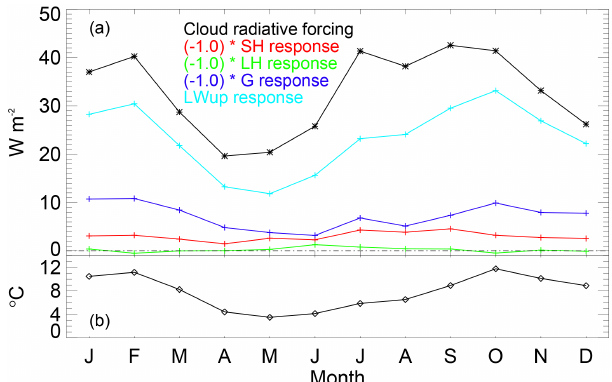
Figure 11. (a) The annual cycle of cloud radiative forcing (black) from January 2011 to October 2013 (Miller et al., 2015) and es- timated annual cycle of responses, calculated from the values in Fig. 9, of sensible heat flux, latent heat flux, ground heat flux, and LW ↑ . (b) Monthly temperature effect due to clouds, estimated from the difference between the measured LW ↑ and the estimated clear- sky LW ↑ value, for the period January 2011–October